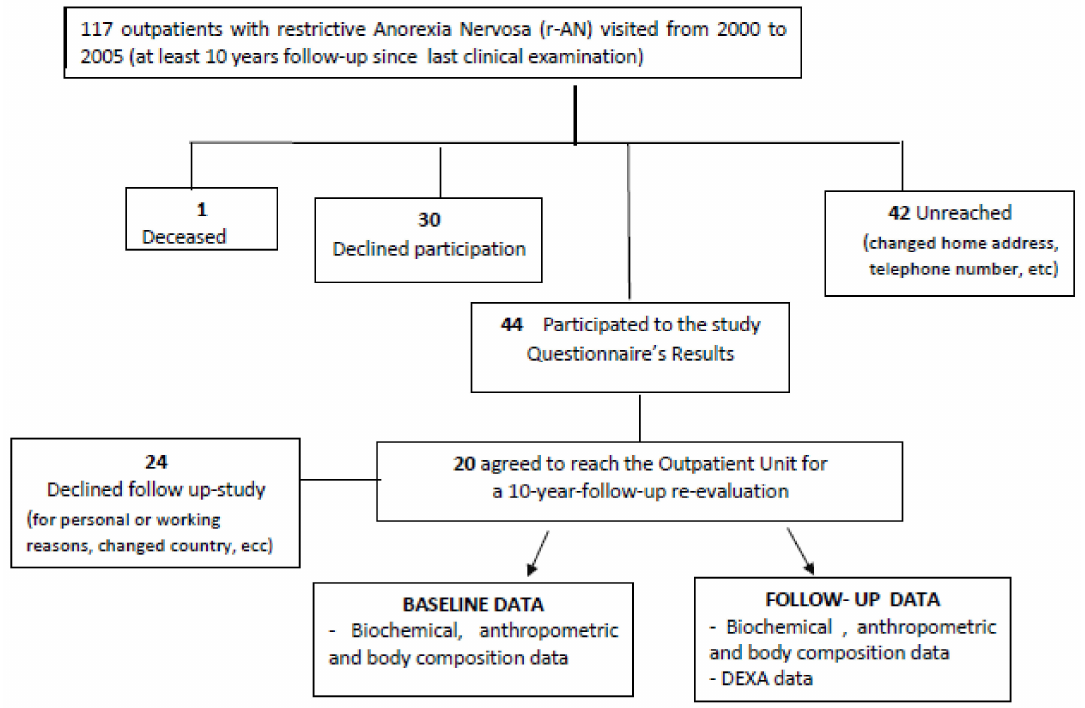
Figure 2. Flow chart describing the di ff erent steps of the patients’ involvement in the